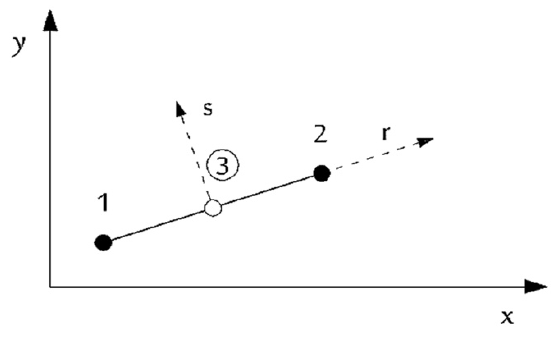
Figure 13. The geometry of the 1D element [26].